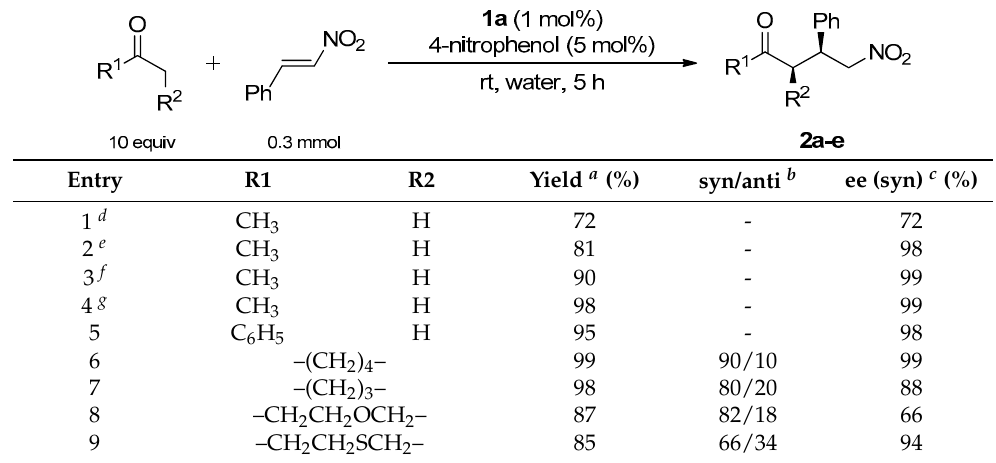
Table 1. Asymmetric Michael reaction of various ketones and α , β -unsaturated nitroalkenes, using a thiourea catalyst.